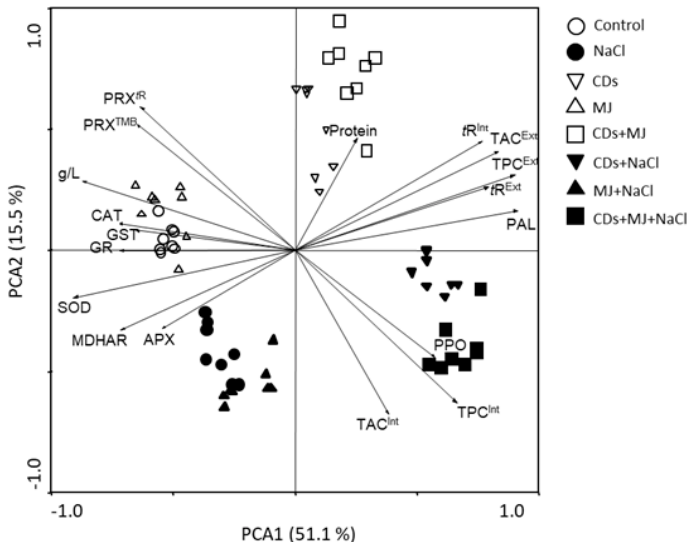
Figure 6. A principal component analysis (PCA) based on the correlation matrix applied to bio- chemical and enzymatic activities data sets. The non-saline and saline treatments are represented by unfilled and filled symbols, respectively. Each variable is represented by an arrow; the longer the length of the arrow, the greater its contribution to a given component. The angle between arrows indicates the degree of correlation among variables; the smaller the angle, the higher the cor- relation.